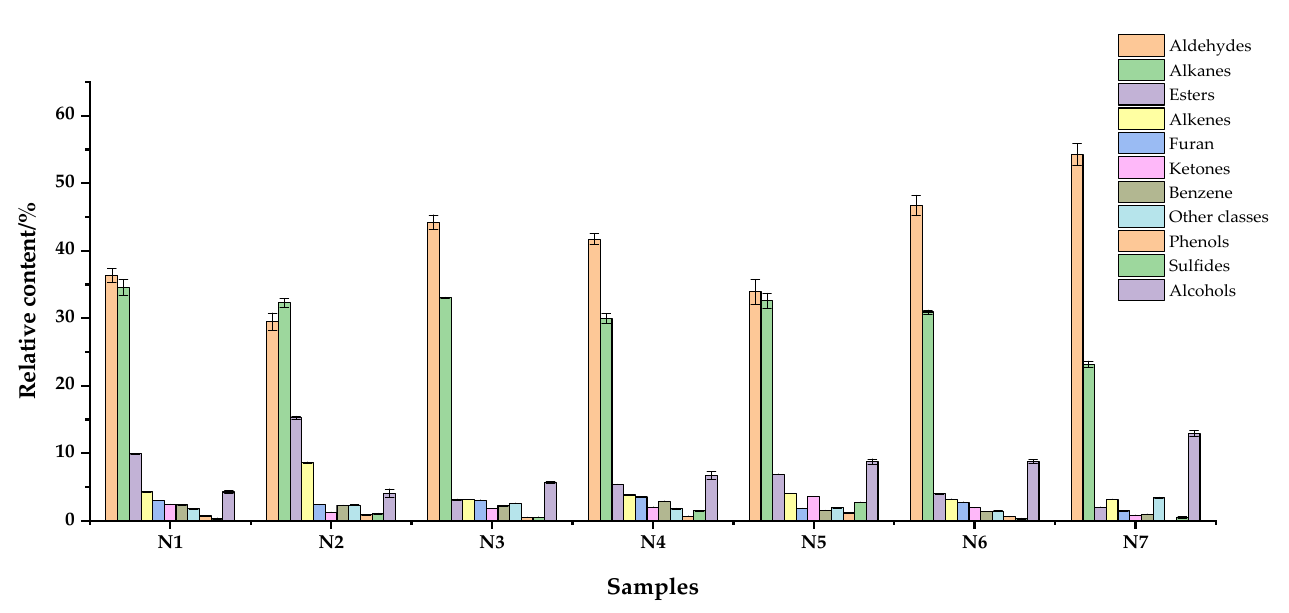
Figure 3. The relative content of volatile compounds in tartary buckwheat noodles. N1–N7 respectively represent noodles with 0%, 10%, 20%, 30%, 40%, 50%, and 60% HTBF.